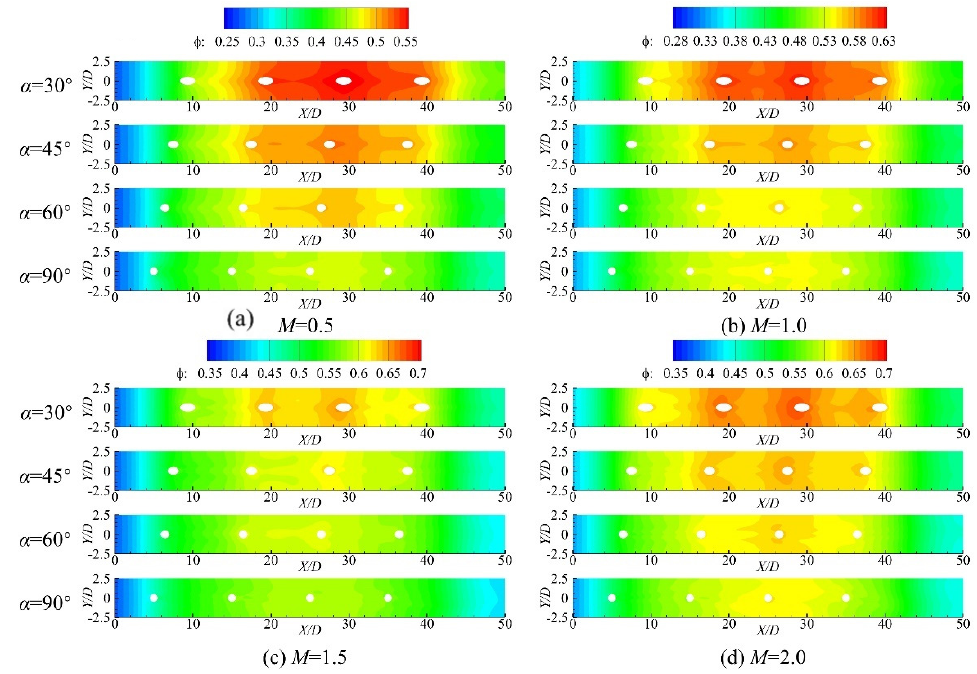
Figure 6. Contours of overall cooling effectiveness for all inclination angled hole cases at each M .